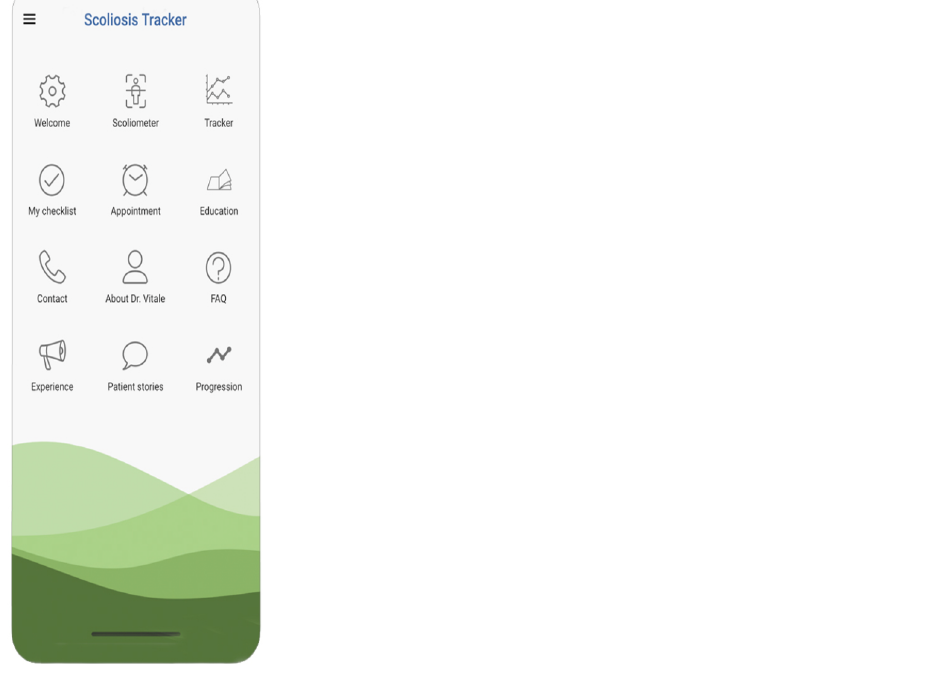
Figure 8. Scoliosis Tracker. (This figure is a snapshot taken by the screen of the